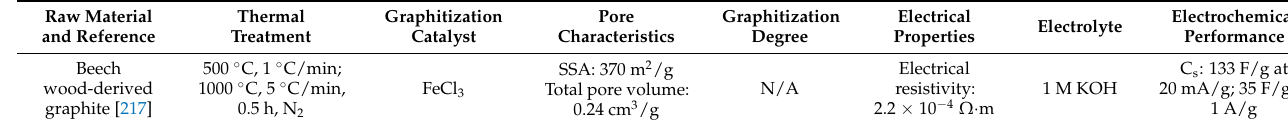
Table 6. Examples of supercapacitors based on lignocellulose-derived